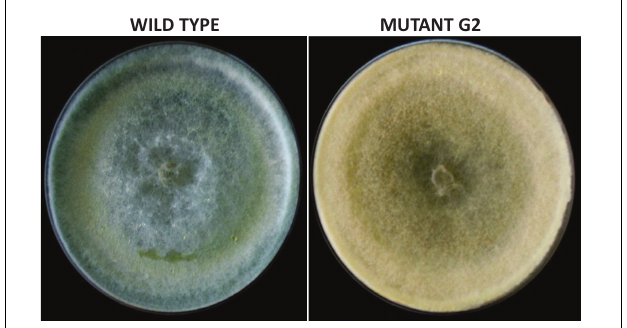
FIGURE 1 | Colony morphology of wild-type and mutant strain of Trichoderma virens , after growth on potato dextrose agar for 5